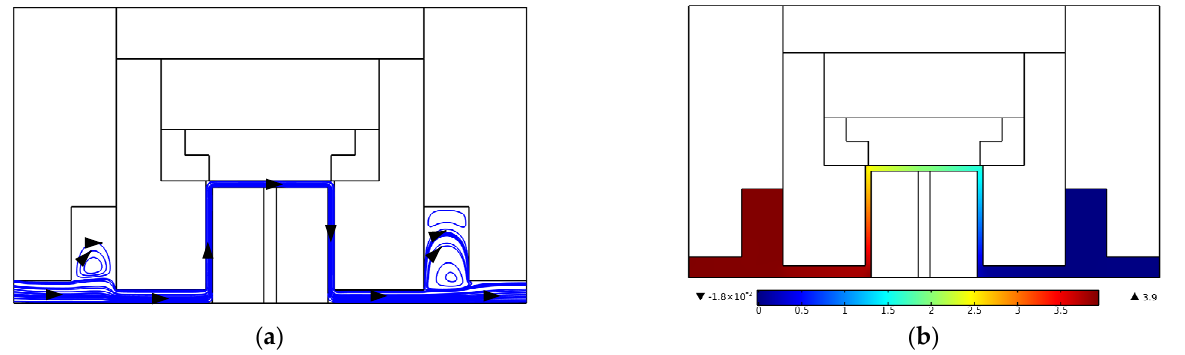
Figure 3. Internal flow field distribution of the MR valve: ( a ) velocity streamlines, ( b ) pressure.